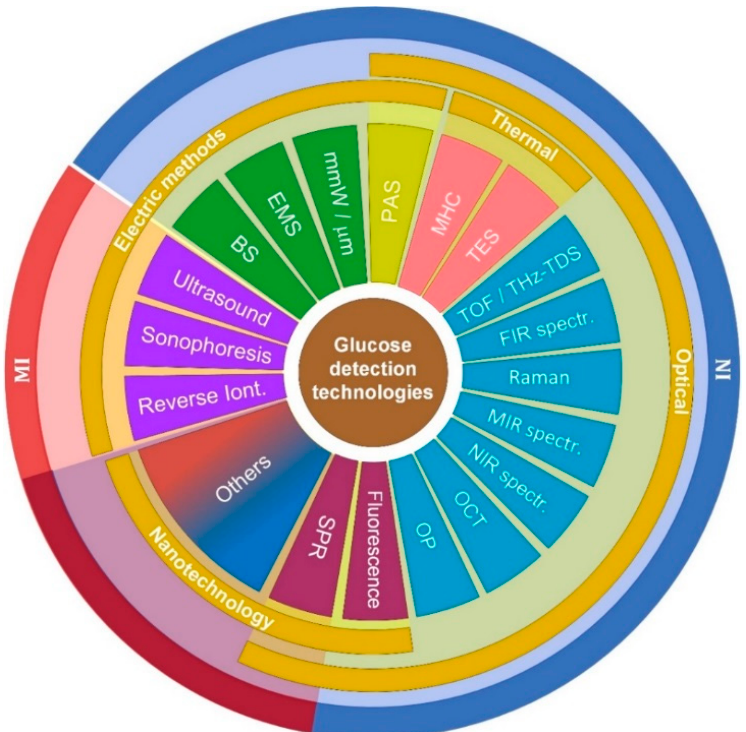
Figure 5. Technologies under development for minimally-invasive and non-invasive glucose detection (SPR-surface plasmon resonance, OP-optical polarimetry, OCT-optical coherence tomography, TOF-time of flight, THz-TDS-Terahertz time domain spectroscopy, TES-thermal spectroscopy, MHC-metabolic heat conformation, PAS-photo-acoustic spectroscopy, mmW-millimeter wave, µ m-Microwave, EMS– Electromagnetic sensing, BS-Bioimpedance spectroscopy).